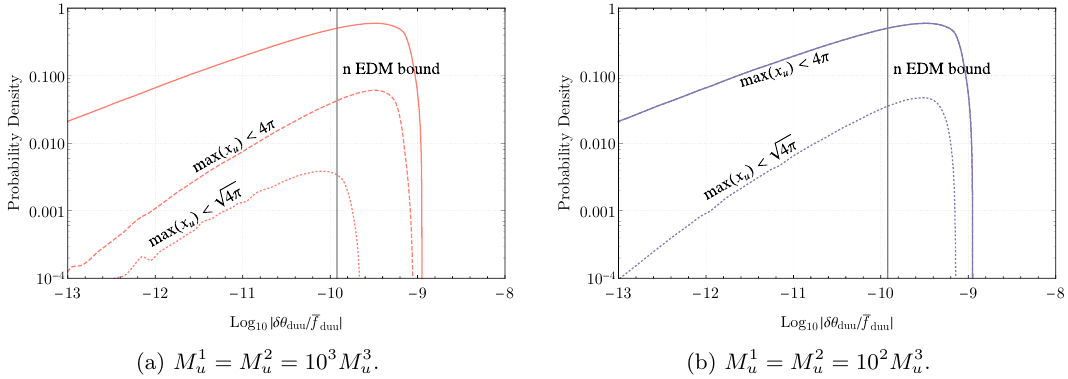
Figure 5. The PDFs of | δθ duu | in eq. (5.2) with b = 1 , 2 and c = 3 normalized by | ¯ f 13 (solid line). We take f M = f M d = M 1 u = M 2 u = 10 3 M 3 u in (a) and f M = f M d = M 1 u = M 2 u = 10 2 M 3 u in (b). After imposing the perturbative unitarity bound of max ( x u ) < 4 π ( expected by the dashed (dotted) lines. Note that the solid and dashed lines overlap in (b). If ¯ f 13 = ¯ f 23 = 1 , the right area of the vertical line is excluded at 90% CL by the neutron EDM duu duu measurement